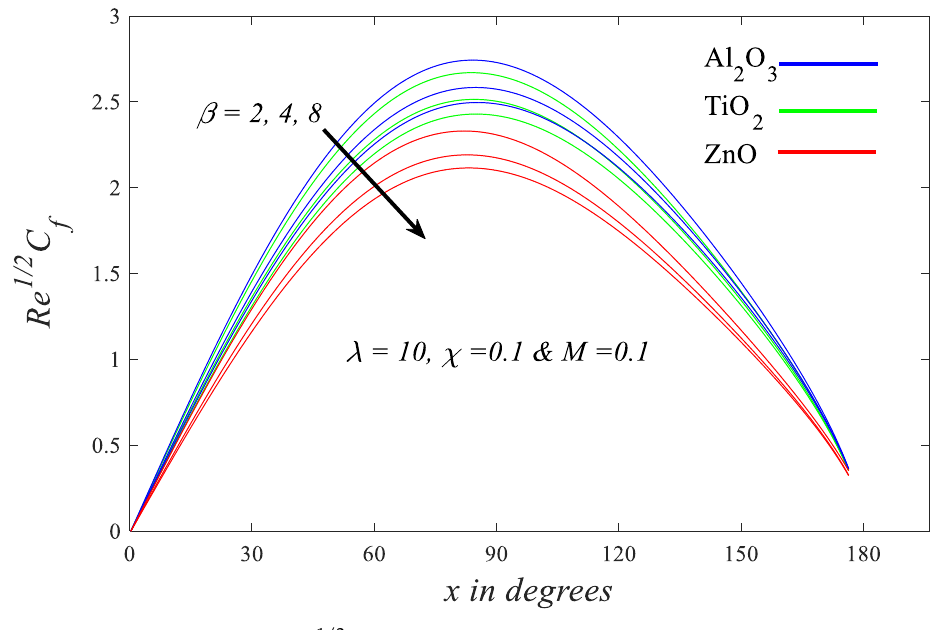
C . Figure 7. Impression of β on Re 1/2 C f . f